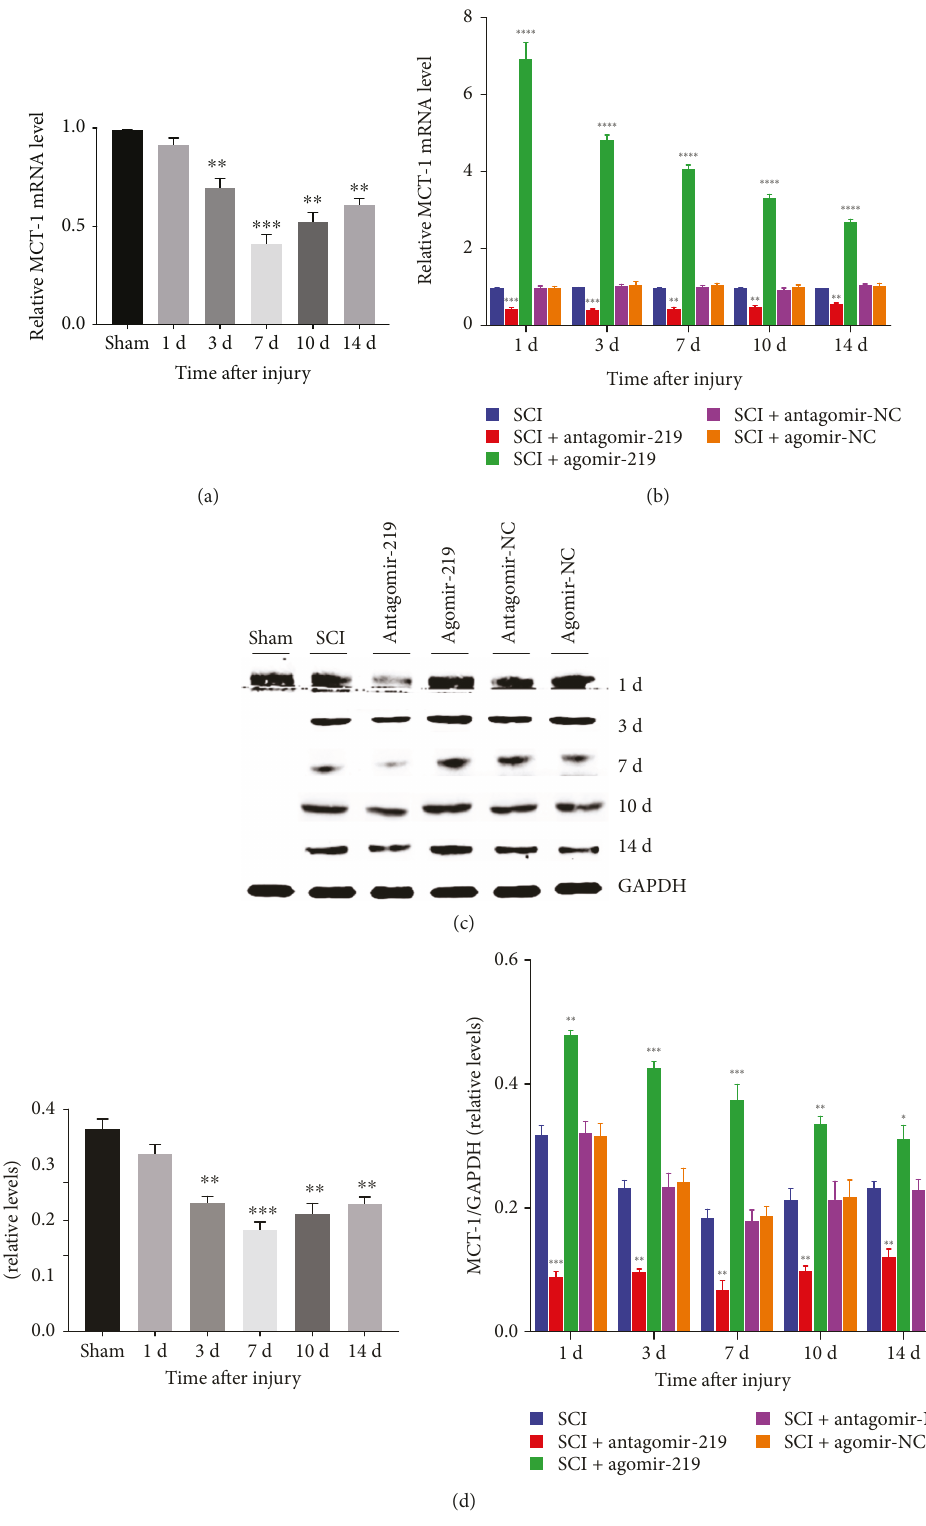
Figure 6: Expression of MCT-1 in di ff erent groups. (a, b) Relative expression level of MCT-1 mRNA detected by qRT-PCR over the time course in all groups. (c, d) MCT-1 protein level of di ff erent groups at all time points was detected by western blotting. Each bar represent the means ± SEM for triplicate experiments. ∗ p < 0 05 , ∗∗ p < 0 01 , ∗∗∗ p < 0 001 , and ∗∗∗∗ p < 0 0001 . MCT-1: monocarboxylate transporter 1; NC: negative